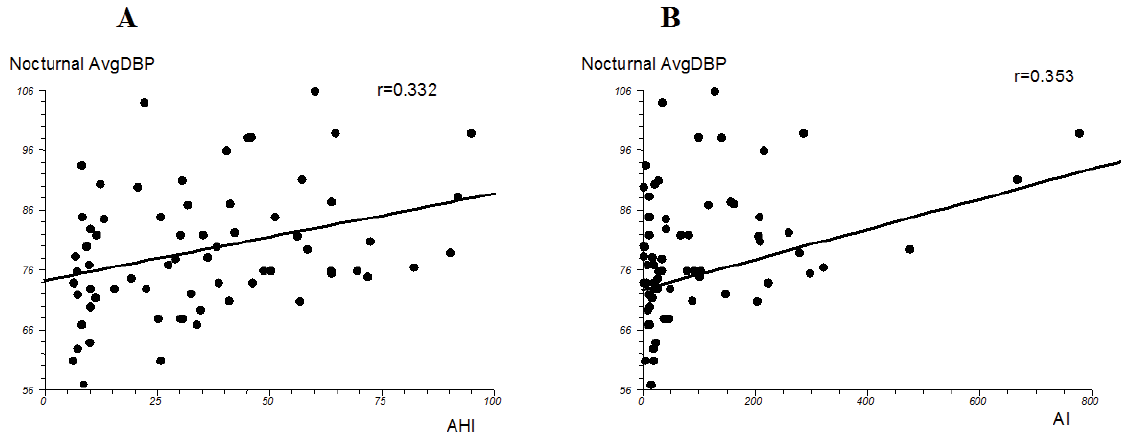
) <85% in minutes (A) and 2